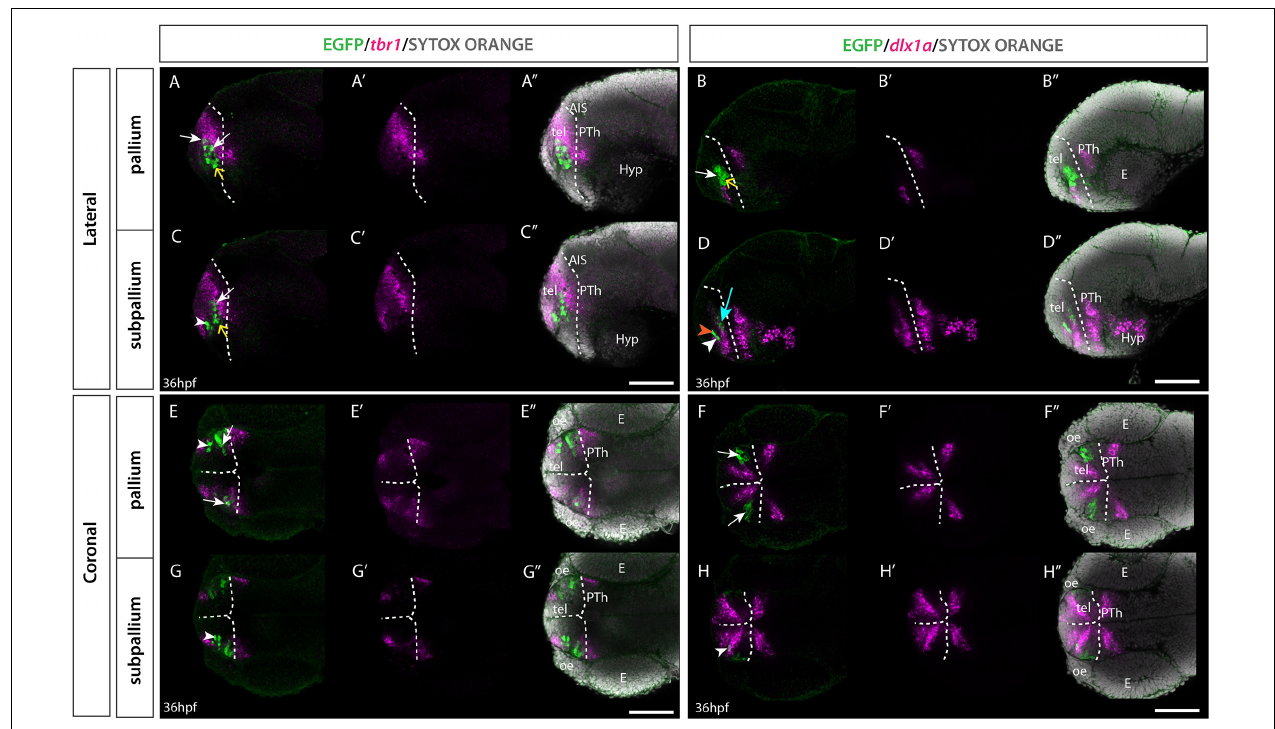
FIGURE 5 | Et( gata2:EGFP ) bi105 line expression in combination with tbr1 and dlx1a markers. Sagittal (A–D (cid:48)(cid:48) ) and horizontal (E–H (cid:48)(cid:48) ) sections through a 36hpf Et (gata2:EGFP) bi105 fish labeled with anti-GFP (green) and FISH for tbr1 (magenta) (A,A (cid:48)(cid:48) ,C,C (cid:48)(cid:48) ,E,E (cid:48)(cid:48) ,G,G (cid:48)(cid:48) ) or dlx1a (magenta) (B,B (cid:48)(cid:48) ,D,D (cid:48)(cid:48) ,F,F (cid:48)(cid:48) ,H,H (cid:48)(cid:48) ) with cell nuclei stained with sytox orange (gray). All images are single confocal z-slices taken from volumes, rostral to the left. White arrows indicate pallial EGFP+ cells that express tbr1 and do not express dlx1a. White arrowheads indicate subpallial EGFP+ cells that express dlx1a and do not express tbr1. Yellow arrows indicate EGFP+ cells located ventral in the pallial domain [population B] that do not express tbr1 or dlx1a. (D) Orange arrowhead shows a subpallial EGFP+ cell that does not express dlx1a. Cyan arrow shows a medial pallial cell that expresses dlx1a . Dotted white line indicates the telencephalic ventricle. Scale bars: 50 µ